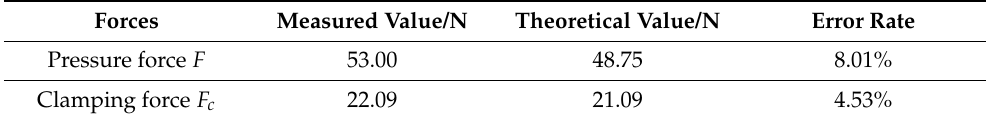
Table 3. Comparison of